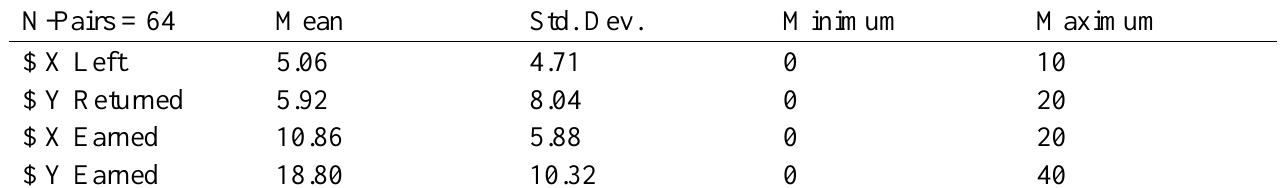
Table A5. Treatments CH4 and CH5 pooled common property trust game data.